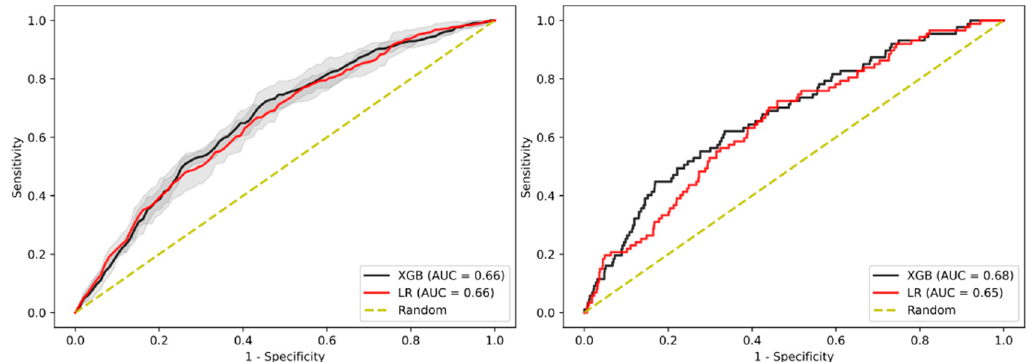
Figure 1. AUC-ROC performance of the XGBoost-based model and Logistic Regression (LR)-based model to identify patients with advanced adenoma (AA) for internal validation cohort ( left ) and test cohort ( right ). Confidence intervals of 95% are shown in shaded grey.